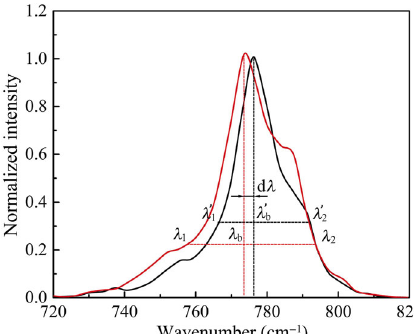
Fig. 4 Schematic of calibrating peak position shift based on barycenter method.